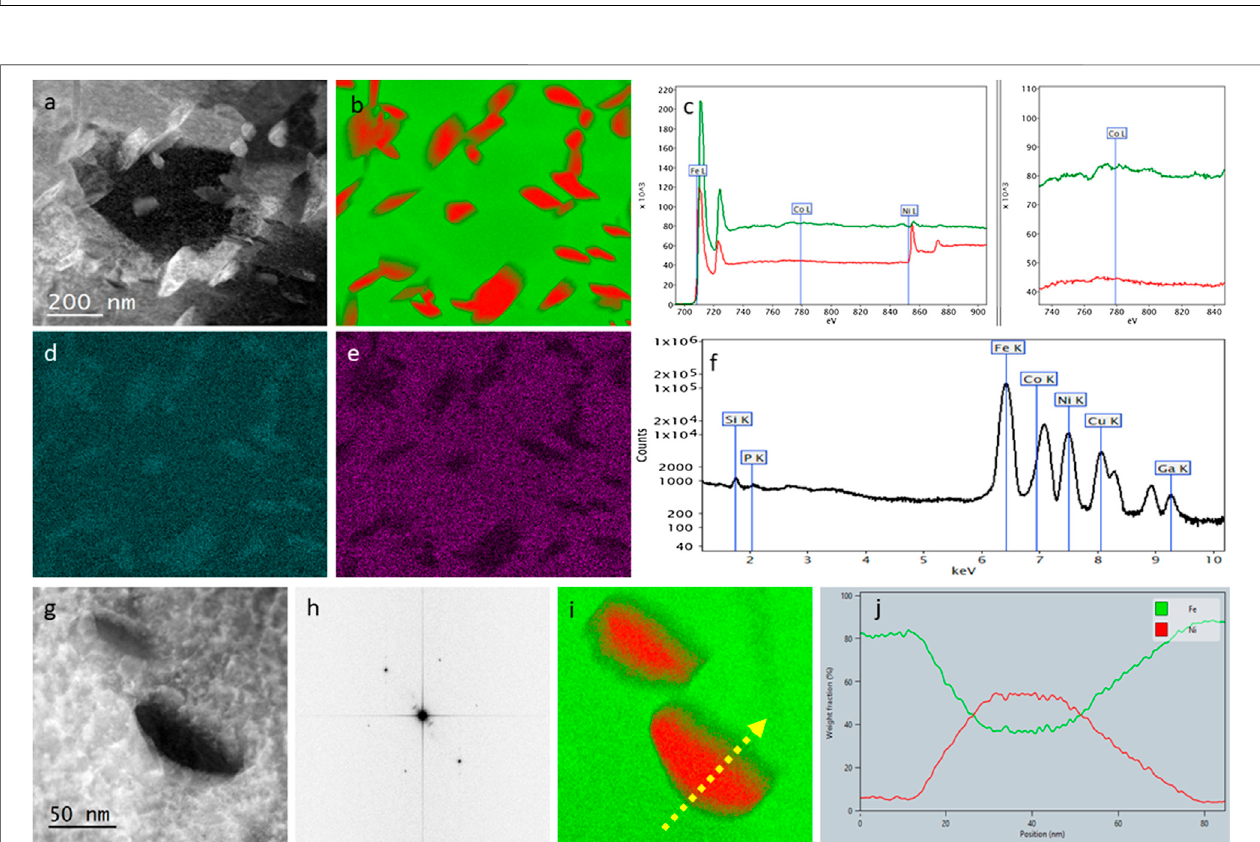
FIGURE2|(A) HAADFimage oftaeniteneedlesinkamacite matrix; (B) composite image ofEDXS maps: red-Ni andgreen-Fe, (C) EELSspectrumfromthematrix (notethelowCosignal), (D) SiEDXSmaps, (E) CoSIEDXSmap, (F) EDXSspectrumsumoverthewholearea(notethelowPpeak), (G) HAADFimageoftaeniteneedles in kamacite matrix, (H) Fast Fourier Transform of an area at higher magni fi cation in (G) that indicates the [111] zone axis of cubic kamacite; (I) composite image of EDXS maps: red-Ni and green-Fe, (J) element pro fi le over taenite needle and kamacite phase (concentrations in wt%).